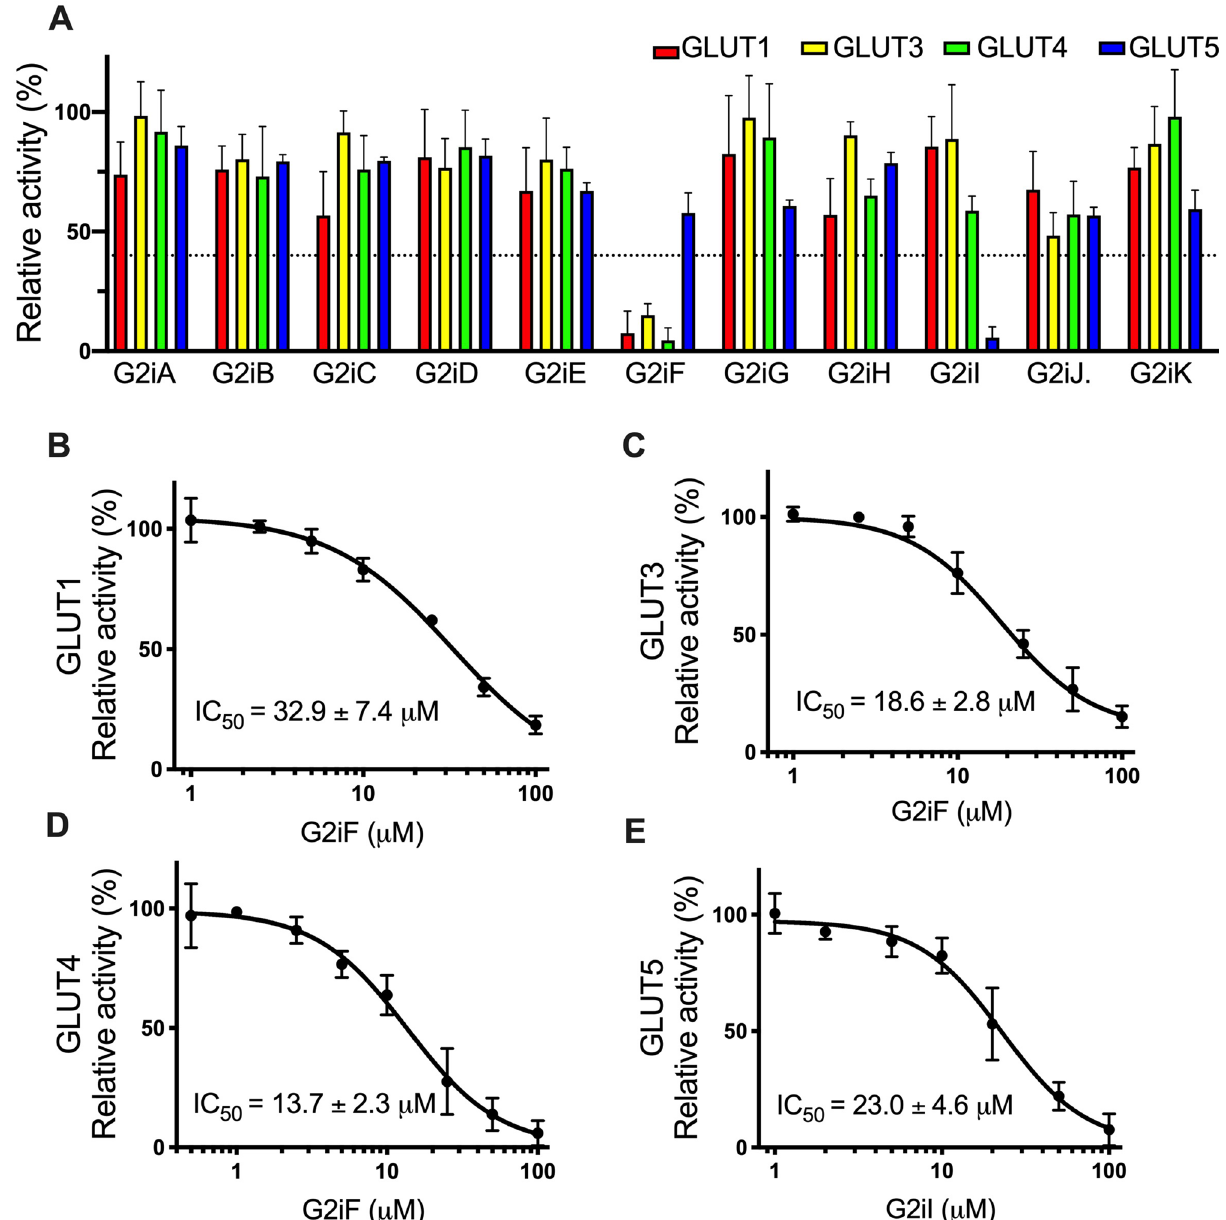
Figure 3. Effect of GLUT2 inhibitors on GLUT1, GLUT3, GLUT4, and GLUT5. ( A ) Relative transport activity of GLUT1 (red), GLUT3 (yellow), GLUT4 (green), and GLUT5 (blue) in the presence of 100 µM of GLUT2 inhibitors G2iA-G2iK. Dose–response curves for G2iF inhibition in GLUT1 ( B ), GLUT3 ( C ), and GLUT4 ( D ), and G2iI inhibition in GLUT5 ( E ). Substrate conditions for relative transport activity were: 1.5 mM glucose for GLUT3, 5 mM glucose for GLUT1 and GLUT4, and 10 mM fructose for GLUT5. Error bars show standard deviation from at least three independent